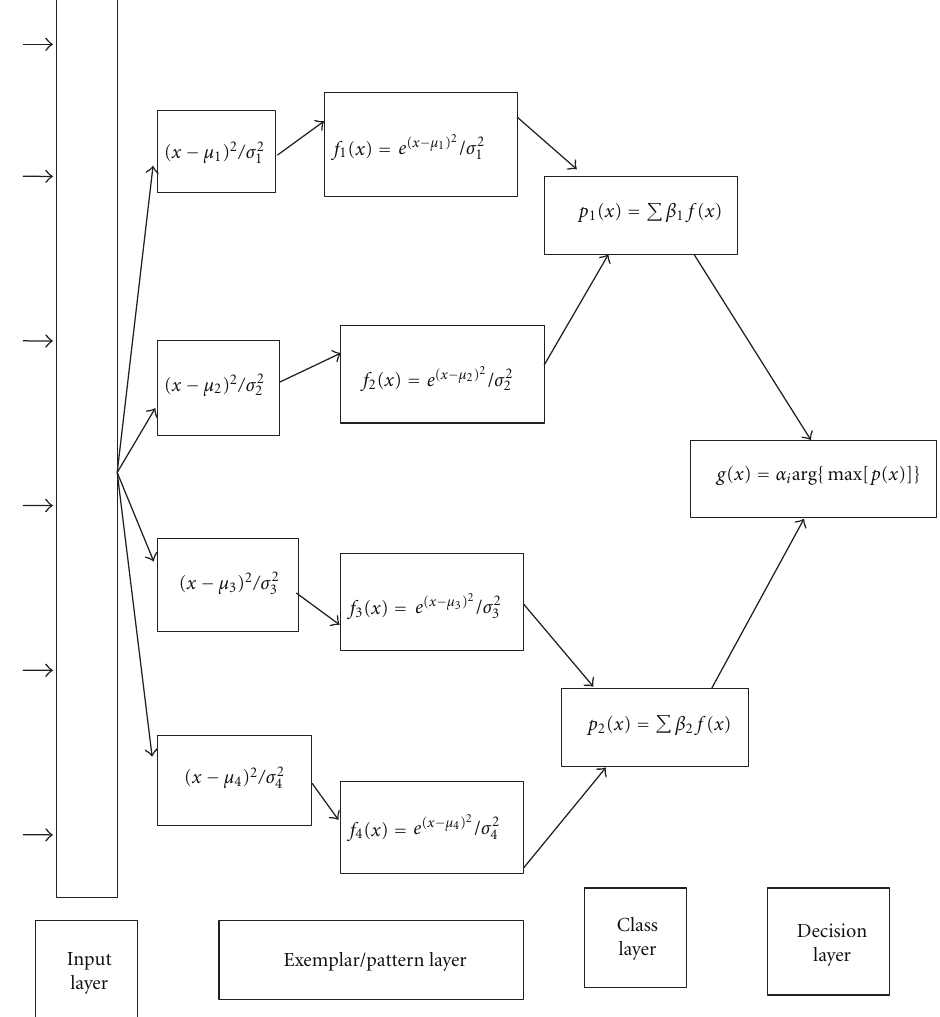
Figure 1: Architecture of probabilistic neural network.